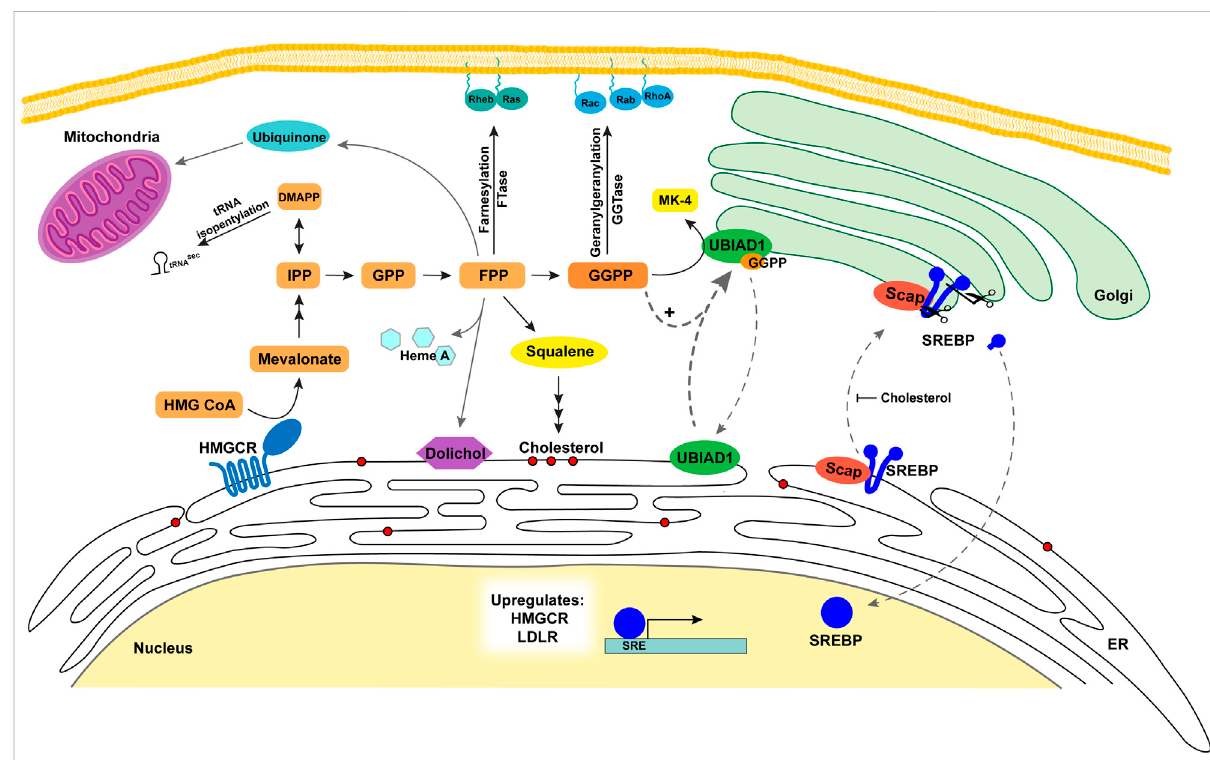
Metabolic roles and regulation of sterols and nonsterol isoprenoids in the cell. The Scap-SREBP complex is translocated to the Golgi where nuclear transcription factor SREBP-2 is released to increase transcription of HMGCR, LDLR, and other cholesterol biosynthetic enzymes. HMGCR expression is increased and catalyzes the conversion of HMG CoA to mevalonate increasing fl ux through the mevalonate pathway. The nonsterol metabolites (orange/yellow) serve as precursors for a variety of nonsterol isoprenoids that are vital for a number of cell processes. DMAPP is utilizedfortRNAisopentenylation.FPPisconvertedtodolicholusedinproteinglycosylationintheER,hemeA,andubiquinoneforthemitochondria. FPP and GGPP are used for prenylation of proteins targeting them to membranes. GGPP is utilized with menadione for the formation of MK-4 by UBIAD1intheGolgi.UBIAD1 cyclesbetweentheERandtheGolgimonitoring GGPPlevels.AsGGPPlevels increaseitbindsUBIAD1andisretainedin theGolgi.FPPisalso converted tosqualene andisthe fi rstmetabolite committed tothesterolsynthesisbranch ofthepathway (redcirclesrepresent sterols). As cholesterol levels increase in ER membranes this inhibits Scap escorting SREBP to the Golgi for activation and oxysterols trigger Insig binding to HMGCR resulting in ERAD. Abbreviations: Scap, SREBP cleavage activating protein; SREBP, sterol regulatory element binding proteins; LDLR, low density lipoprotein receptor; HMGCR, 3-hydroxy-3-methylglutaryl (HMG) Coenzyme A reductase; IPP, isopentenyl